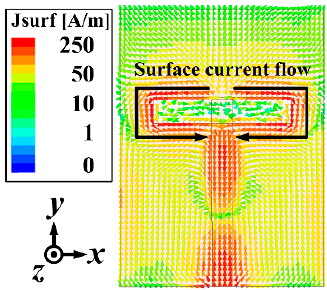
Figure 3. Surface current distribution of slotted aperture at 24.125 GHz.